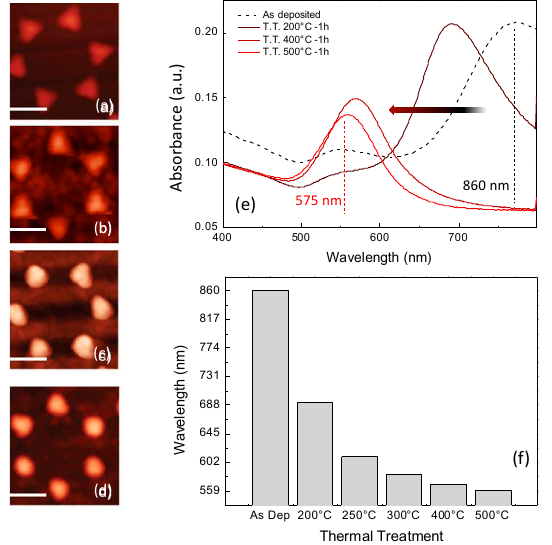
Figure 5. ( a – d ) High-resolution AFM images showing the morphological evolution of the realized gold nanoprism upon thermal annealing. ( e ) Absorption spectra modification of the as deposited metal nanostructures after thermal treatments with increasing temperature, for 1 h; ( f ) the spectral position of the LSPR absorbance peak is plotted as function of the annealing temperature.